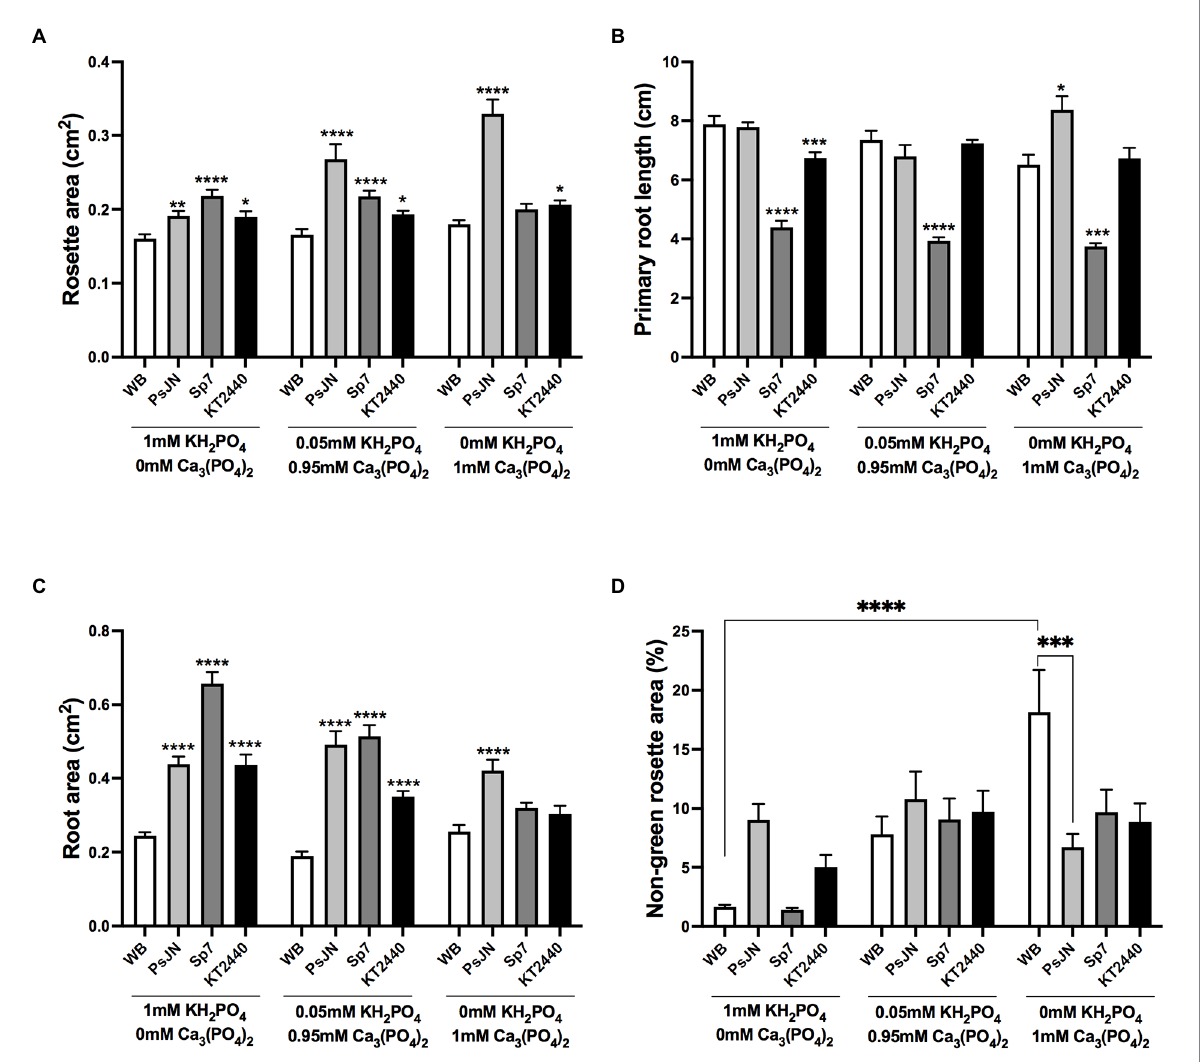
FIGURE 2 Effects of different sources of phosphorus in plant growth and stress parameters in Arabidopsis thaliana inoculated with beneficial rhizobacteria. Rosette area (A) , primary root length (B) , root area (C) , and non-green rosette area (D) in plants 15 days after sowing in media with different concentrations of KH 2 PO 4 or Ca 3 (PO 4 ) as a phosphate source with high or low solubility, respectively (Factor 1). A second factor corresponds to the inoculation, where non-inoculated plants are noted as WB, and inoculations with Paraburkholderia phytofirmans PsJN, Azospirillum brasilense Sp7, or Pseudomonas putida KT2440 are noted as PsJN, Sp7, and KT2440, respectively. Data are means ± SE of 30 replicates per treatment. In the case of A and B panels, asterisks indicate significant differences between each treatment and their respective WB treatment (Kruskal–Wallis test, * p < 0.05; ** p < 0.01; *** p < 0.001; and **** p < 0.0001). For panel C, only some significant differences are indicated with lines as asterisks, according to a Two-Way ANOVA with multiple comparisons * p < 0.05; ** p < 0.01; *** p < 0.001; and **** p <